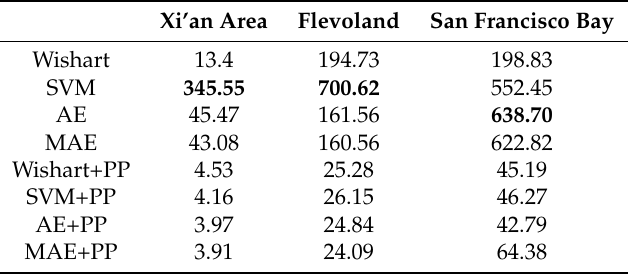
Table 12. Predicting time for all pixels in three PolSAR images with different methods